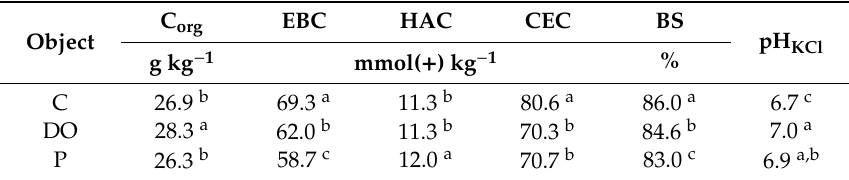
Table 2. Physicochemical properties of uncontaminated soil (C) and polluted with diesel oil (DO) and unleaded petroleum (P).